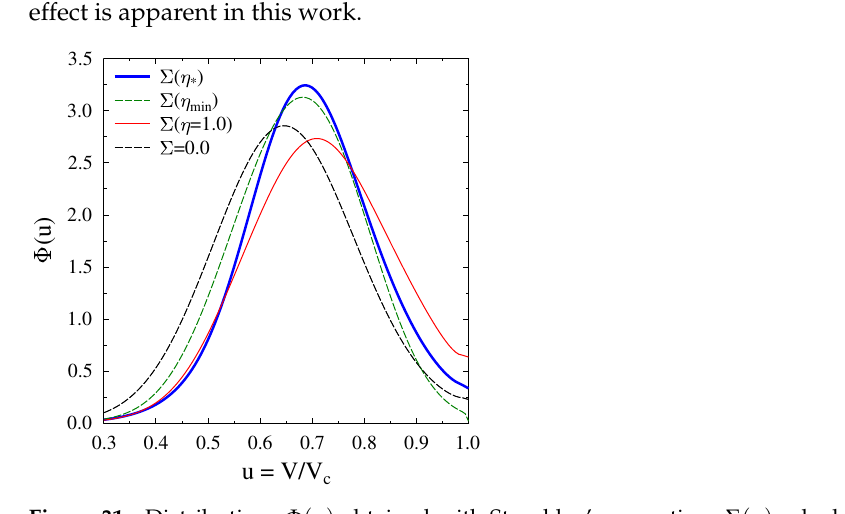
Figure 31. Distributions Φ ( u ) obtained with Stoeckley’s corrections Σ ( η ) calculated for different values of η : η = η ∗ ; η = η min ; η = 1.0 and η = 0.0. Adapted from Zorec et al. [127]. Because the distribution Φ ( u ) of ratios u = V / V c depends on Stoeckley’s correction Σ lower possible rotational parameter η min , i.e., the value derived when we consider that V ( η min ) = V sin i (dashed green line); (b) Stoeckley’s corrections estimated for the critical rotation, i.e., V ( η = 1 ) = V c (red line); (c) neglecting Stoeckley’s correction, i.e., η = 0.0 in all stars (black dashed line); (d) Stoeckley’s corrections estimated for η = η ∗ derived for each star individually (blue full line). As expected, approximation (a) produces a slight excess of slow rotators (dashed green line); solution (b) is characterized by an excess of rapid rotators; (c) the distribution is shifted to smaller values of u = V / V c